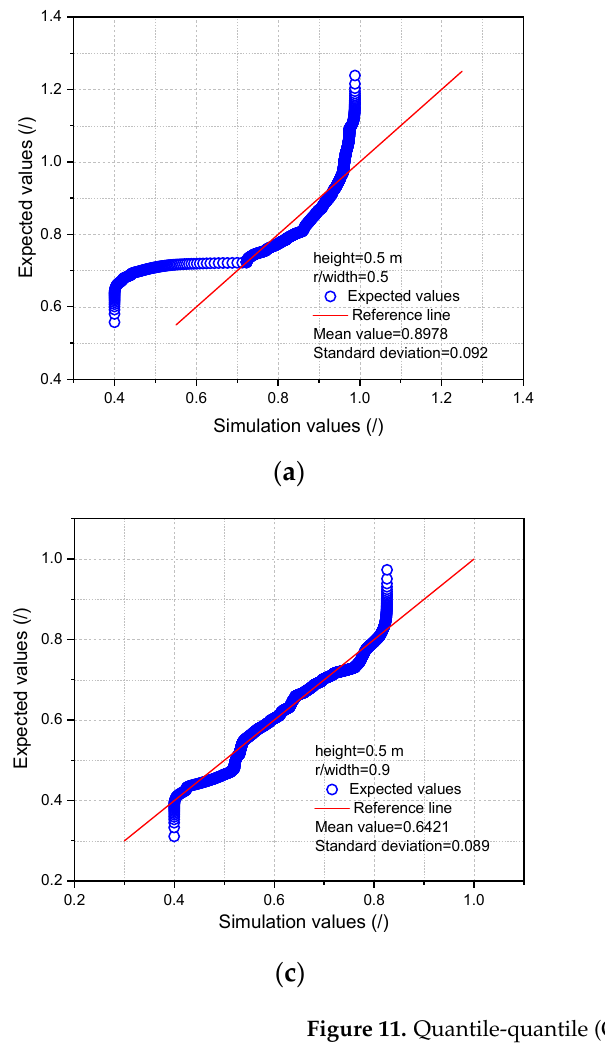
Figure 10. Comparisons of averaged axial velocities of particles with density of ρ p = 2700 kg/m 3 and ρ p = 800 kg/m 3 at the height of 0.24 m and 0.5 m. Figures 11 and 12 show the quantile–quantile (Q-Q) plots of central and wall porosity of particles used in experiment at the height of 0.24 m and 0.5 m, r/Width = 0.5 and 0.9, ρ p = 800 kg/m 3 and ρ p = 2700 kg/m 3 , respectively. This figure demonstrates whether the distributions for a random variable are a Gaussian distribution. The Y axis is the quantile of the samples, and the X axis is the quantile of normal distributions. The primary reason is that the multiphase flow is affected by the complex turbulence diffusions, anisotropic particle dispersion, and particle inertia. The variations of particle porosity reflect the change of drag force, leading to the particle randomly falling into the bubble’s inside and the variation of the bubble’s retaining time in an unstable fluid–particle system.